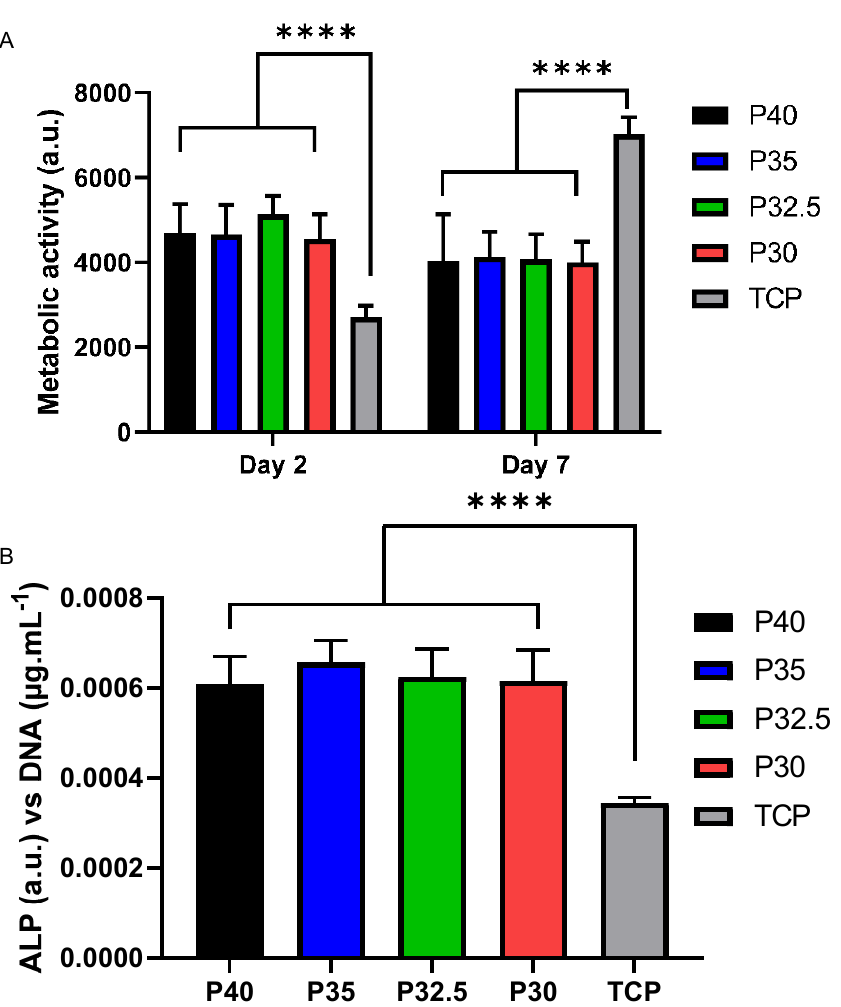
Figure 9. ( A ) Evaluation of cell metabolic activity in direct culture of porous microspheres at day 2 and day 7. **** p < 0.0001. ( B ) Evaluation of ALP activity in direct culture with porous microspheres at day 7. **** p < 0.0001.